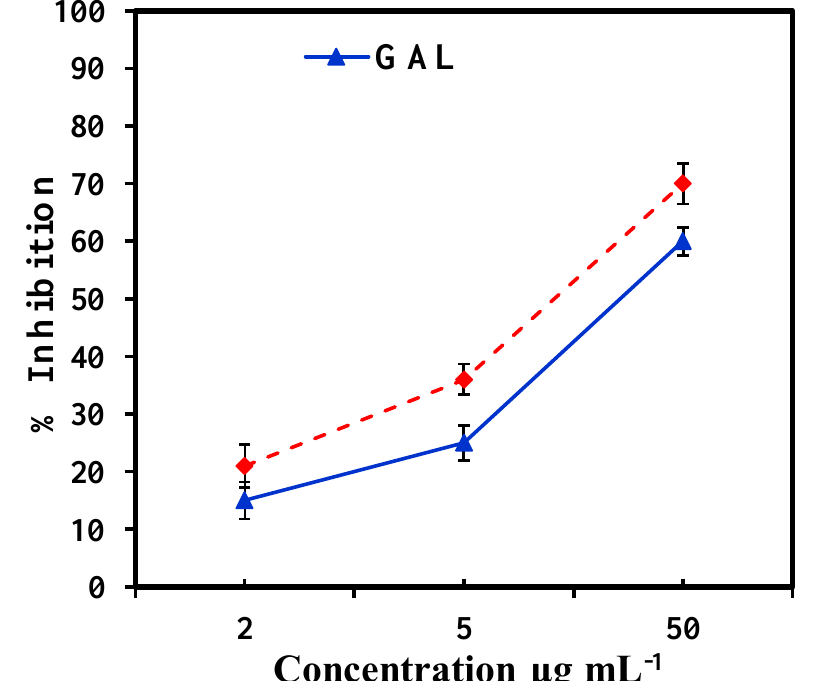
Figure 3: The antioxidant activity of pure galangin (Blue color) and galangin / β-cyclodextrin (Red color) as measured by linoleic acid model system at three different